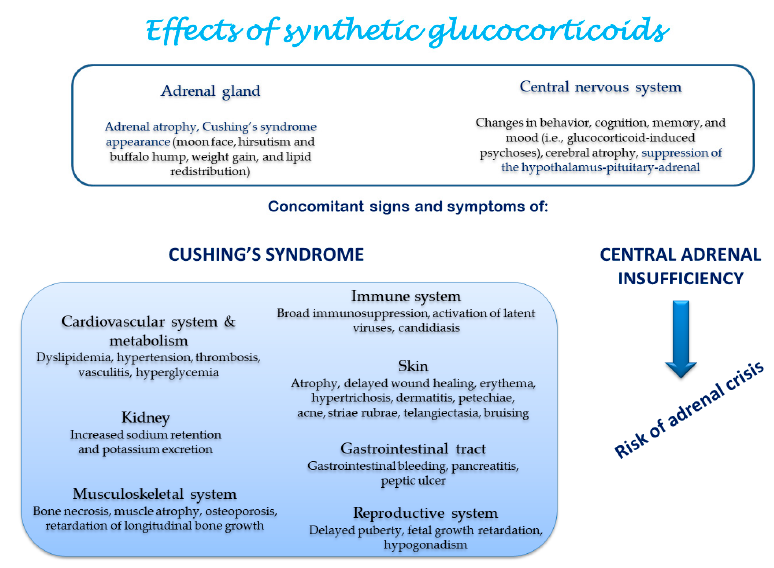
Figure 3. Tissue side effects of synthetic glucocorticoids [1].